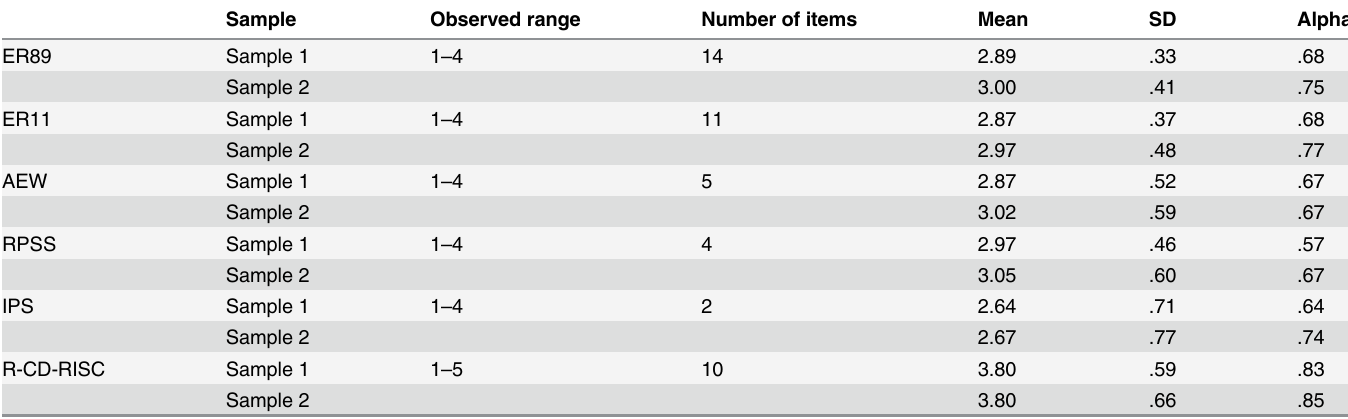
Table 3. Descriptive Statistics and Internal Consistencies of Different Versions of Ego-resiliency Scales.